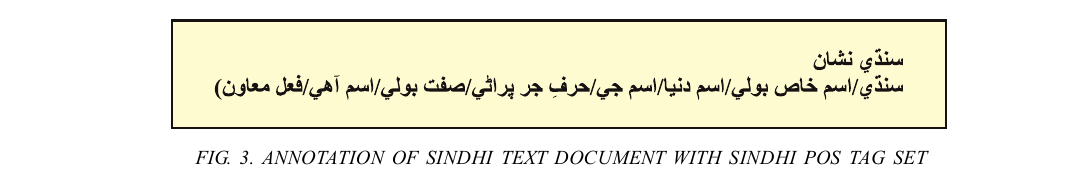
FIG. 3. ANNOTATION OF SINDHI TEXT DOCUMENT WITH SINDHI POS TAG